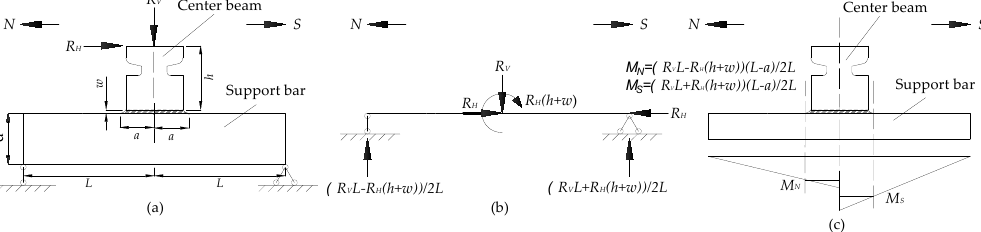
Figure 12. Mechanical analysis of CB/SB joint under the test load. ( a ) Details of the CB/SB joint. ( b ) Mechanical model of support bar. ( c ) Bending moment diagram of the support bar.